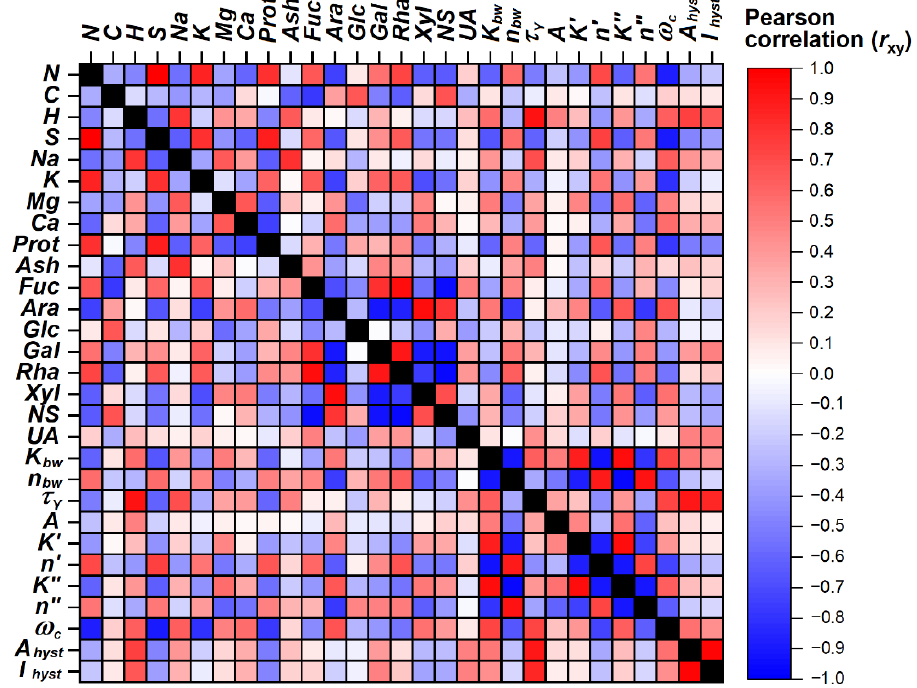
Figure 4. Correlation matrix of Pearson correlation coefficients r xy calculated for the analytical values obtained for the FSM samples ( N = 10).